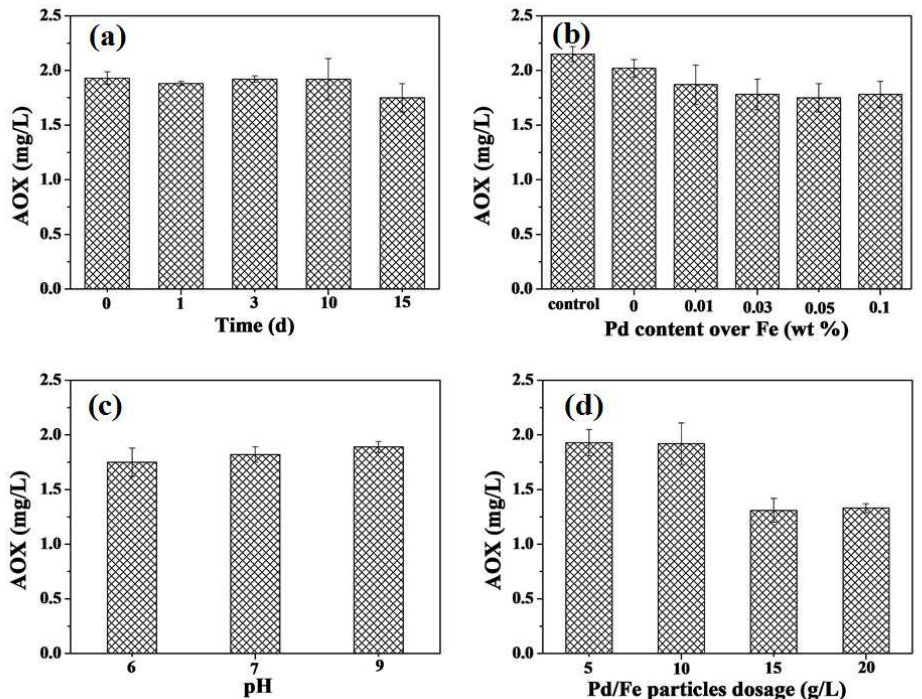
Figure 6. Concentration changes of AOX in supernatant: ( a ) effect of reaction time (Pd/Fe powder = 10 g/L, Pd loading = 0.05 wt %, pH 6.0), ( b ) effect of Pd loading (Fe powder = 10 g/L, Pd/Fe powder = 10 g/L, pH 6.0; reaction time was 15 days), ( c ) effect of initial pH (Pd/Fe powder = 10 g/L, Pd loading = 0.05 wt %; reaction time was 15 days), ( d ) effect of added amounts of Pd/Fe (Pd loading = 0.05 wt %, pH 6.0; reaction time was 10 days).